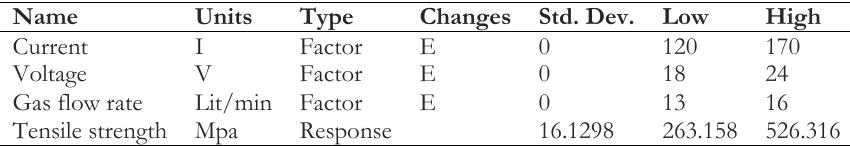
Table 4. Model summary showing highest and lowest values of factors.